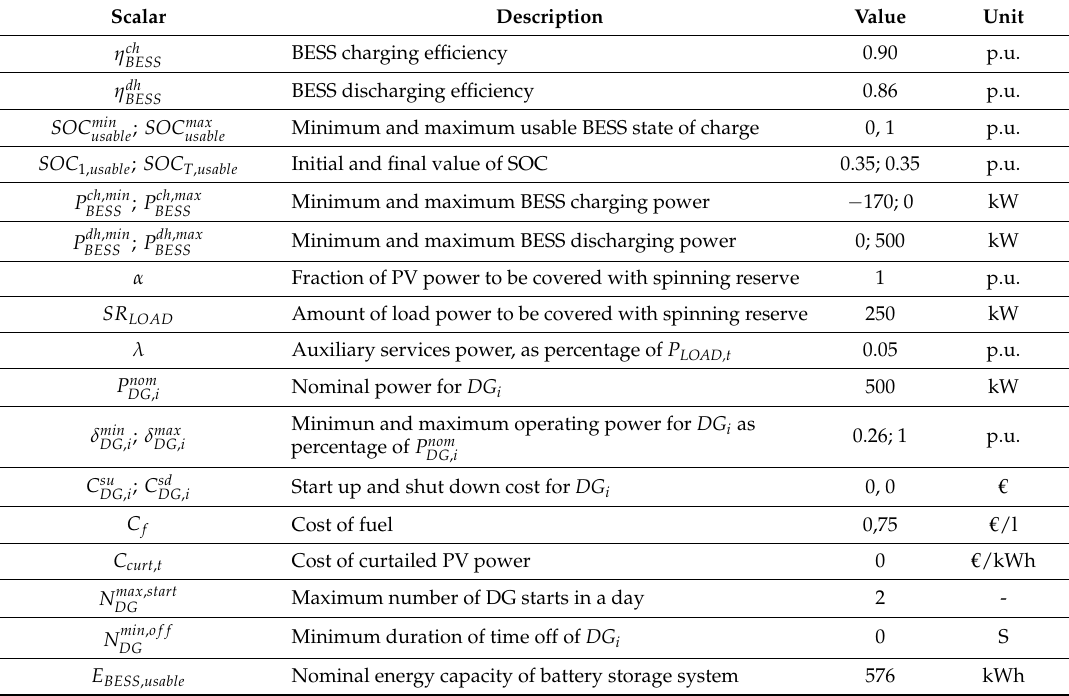
Table 8. List of scalar in the MIP model and set of values used in the case study micro-grid.